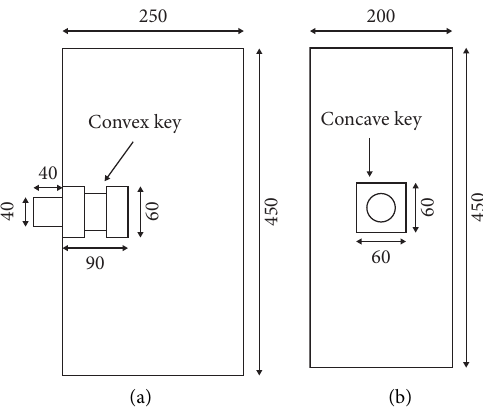
Figure 13: The geometric dimensions of model. (a) Elevation view and (b) section view (unit: